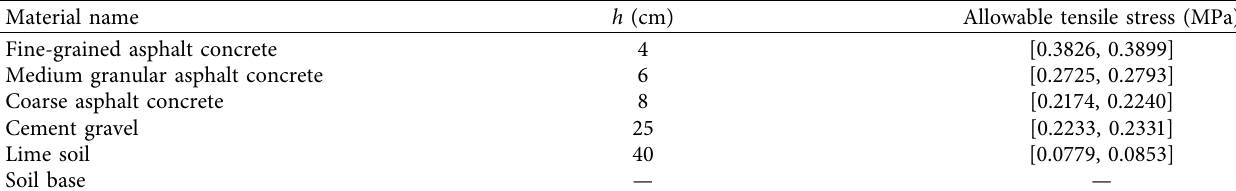
Table 1: Number of allowable tensile stress design intervals for each layer of